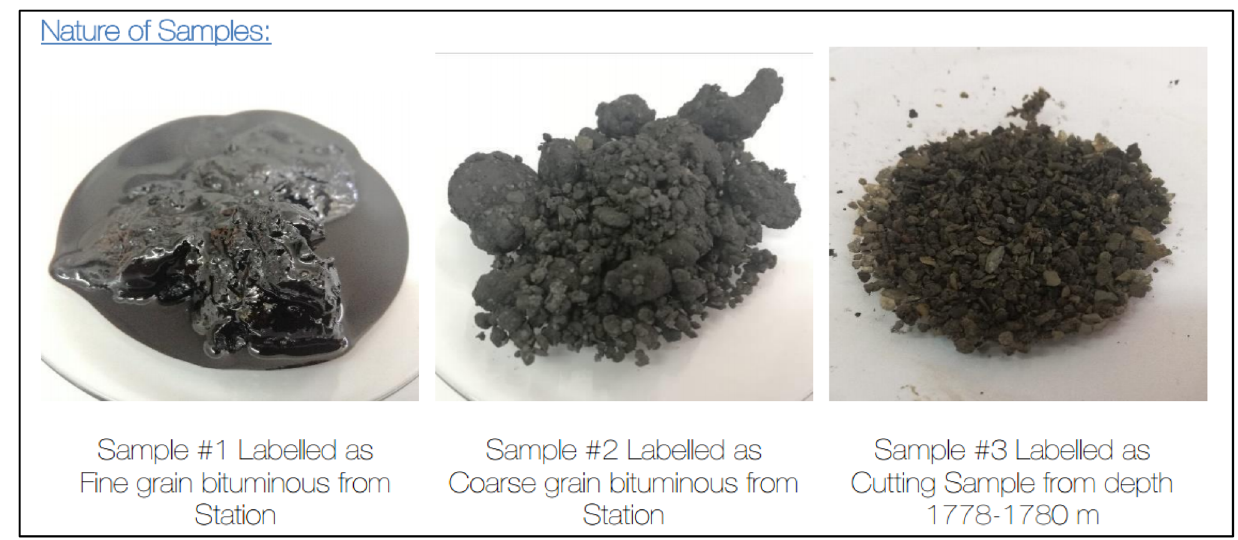
Fig. 17 Lab core analysis and description shows fracture filled by Bitumen